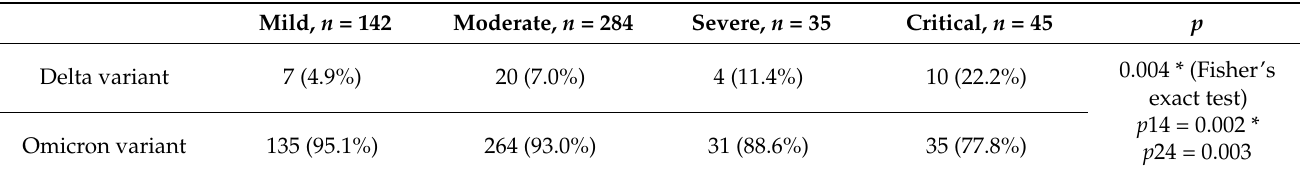
Table 2. Genetics of the virus depending on the severity of COVID-19.